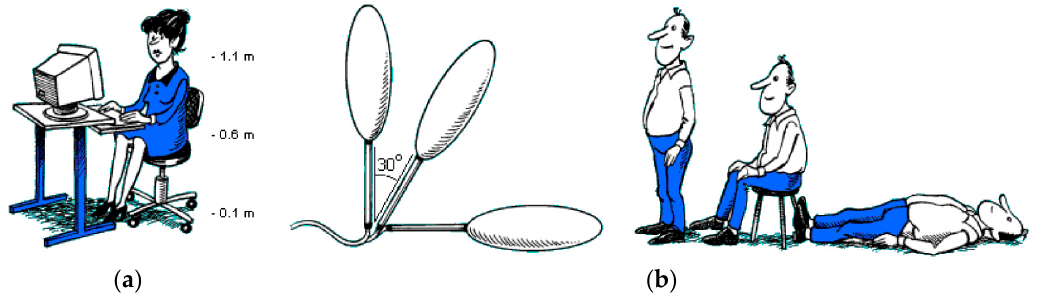
Figure 2. Recommended air velocity probe heights behind the feet, elbow, and neck for a sitting person ( a ); Recommended operative temperature probe person’s angle factor to their surroundings ( b ) [58] .